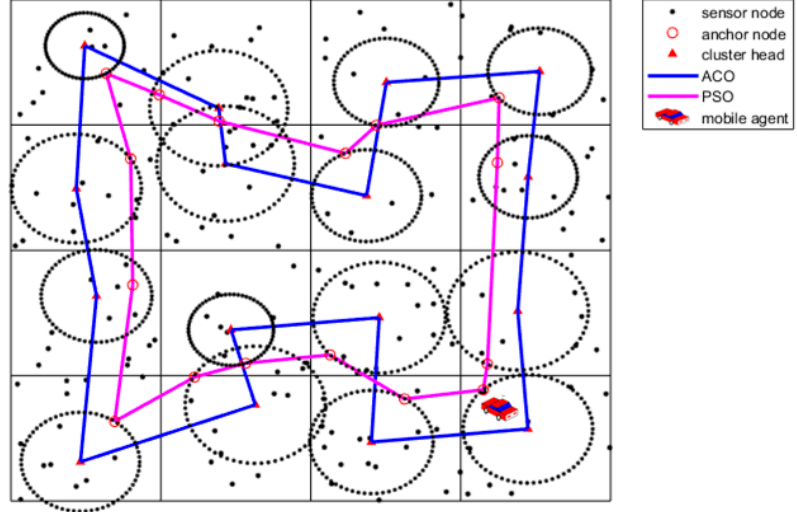
Figure 8. Communication range adjustments.